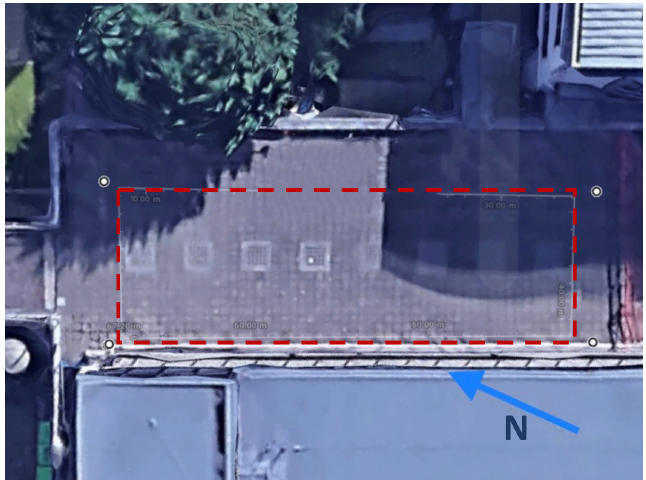
Figure 3. Top view of the data collection trajectory that was set out for each subject. The red dotted line shows the trajectory subjects were asked to